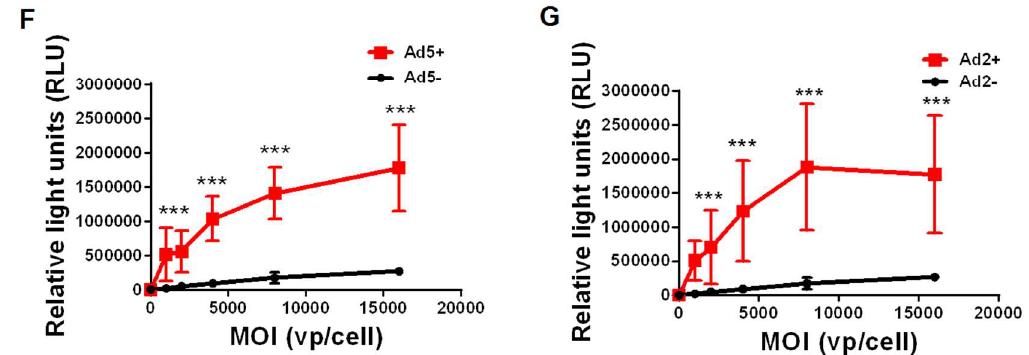
Figure 1. CD14+ monocytes from Ad-seropositive individuals exhibited an increased susceptibility to Ad infection. ( A ) Representative graphics of FACS analysis. Human PBMCs were infected with Ad5-EGFP or Ad2-EGFP, and the proportions of EGFP-positive cells in different cell populations were determined by FACS analysis. Herein, EGFP-positive cells represent those cells that have been infected with Ad5 or Ad2. ( B ) Percentage of EGFP-positive cells in CD14+ cells of Ad seropositive subjects and seronegative subjects after infected with Ad5-EGFP at 1250 vp/cell. ( n = 6). ( C ) Expression level of EGFP protein (represented with MFI value) in CD14+ cells from Ad seropositive subjects and seronegative subjects after infected with Ad5-EGFP at 1250 vp/cell ( n = 6). ( D ) Percentage of EGFP-positive cells in CD14+ cells of Ad seropositive subjects and seronegative subjects after infected with Ad2-EGFP at 1250 vp/cell ( n = 6).( E ) Expression level of EGFP protein (represented with MFI value) in CD14+ cells from Ad seropositive subjects and seronegative subjects after infected with Ad2-EGFP at 1250 vp/cell ( n = 6). ( F ) Percentage of RLU (Relative light units) in PBMC of Ad seropositive subjects and seronegative subjects after infected with Ad5-SEAP at 0, 1000, 2000, 4000, 8000, and 16,000 vp/cell. ( n = 6). ( G ) Percentage of RLU (Relative light units) in PBMC of Ad seropositive subjects and seronegative subjects after infected with Ad2-SEAP at 0, 1000, 2000, 4000, 8000, and 16,000 vp/cell. ( n = 6). The bars represent the standard error. ***: p <